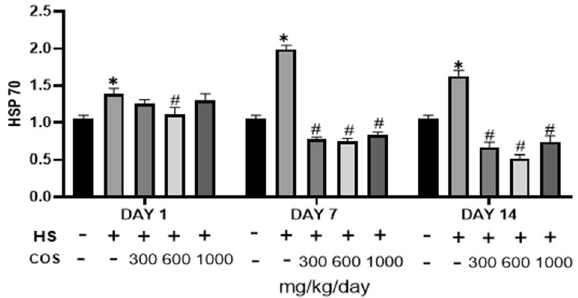
Figure 7. Effects of chitosan on protein expression of HSP70. Control: normal mice; HS: Heat stress mice; COS-LD: mice treated with HS plus COS (300 mg/kg); COS-MD: mice treated with HS plus COS (600 mg/kg); COS-HD: mice treated with HS plus COS (1000 mg/kg). Data are expressed as mean ± standard error. *Indicates p < 0.05 compared with the blank control group, # Indicates p < 0.05 compared with the HS control group.